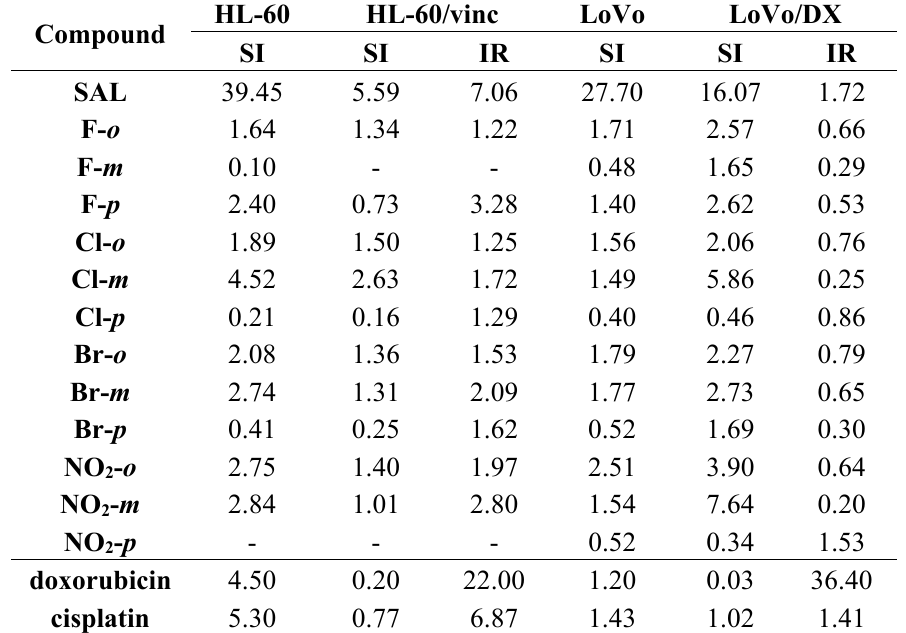
Table 4. The calculated values of the indexes of resistance (IR) and selectivity (SI) of SAL and its N- benzyl